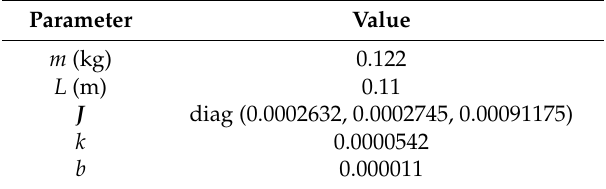
Figure 5. Fitting results of the inclination angles and wind strengths.